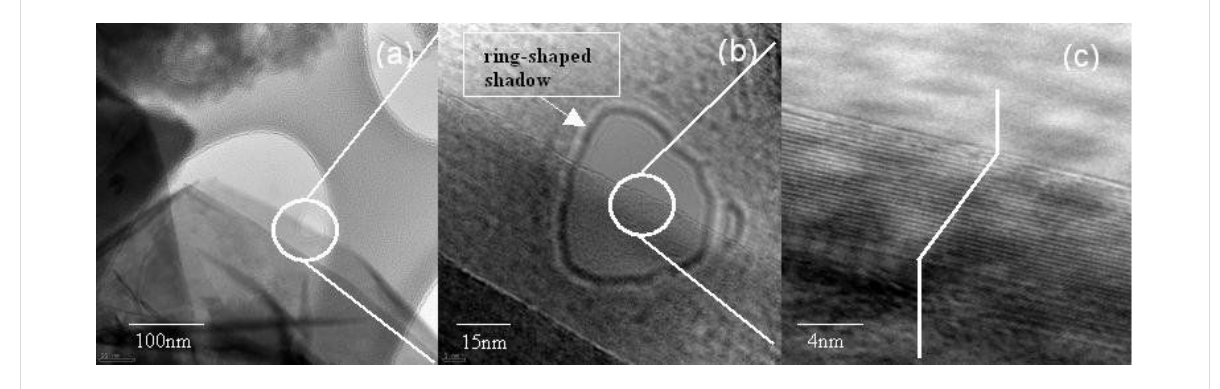
Figure 1: TEM images of BNNSs with different